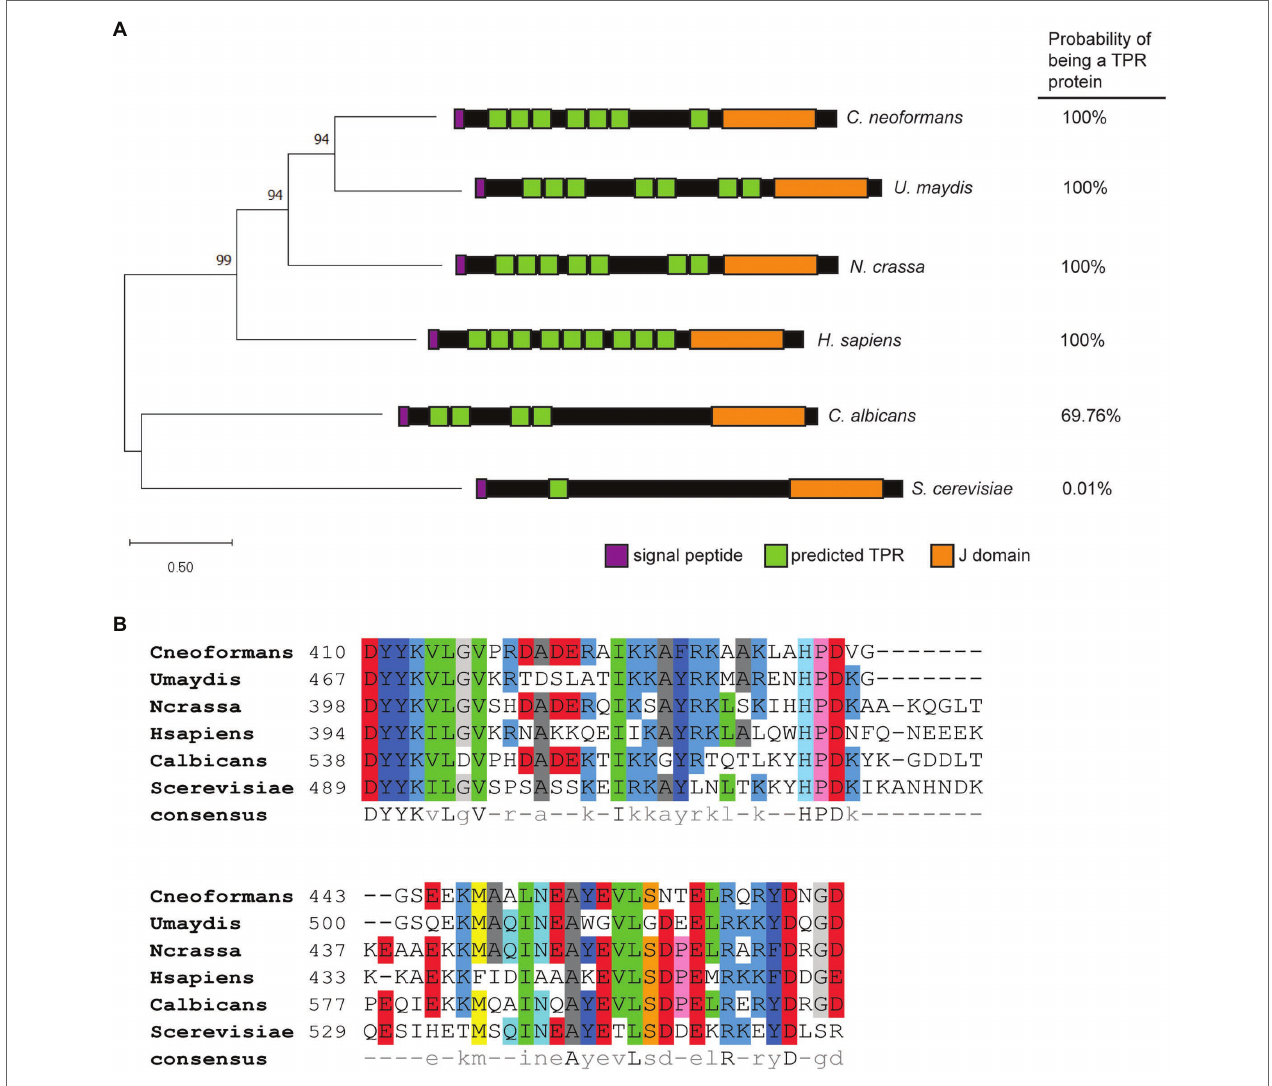
FIGURE 1 | Dnj1 is a tetratricopeptide repeat and J domain-containing protein distinct from the Jem1 proteins in the Saccharomycotina. (A) A Maximum Likelihood tree constructed based on a ClustalW alignment of amino acid sequences of Dnj1 and putative orthologs retrieved from UniProt. The Le Gascuel amino acid replacement matrix was used to build the tree and the bootstrap values of p from 500 bootstrap trees are indicated. A schematic of each protein is shown indicating the predicted TPRs with values of p < 0.01 predicted by TPRpred and the overall probability that each protein is a tetratricopeptide repeat (TPR) is specified. (B) An amino acid alignment of the J domains for the putative ortholog from each indicated species. The consensus amino acid sequence determined using pyBoxshade is indicated at the bottom of the